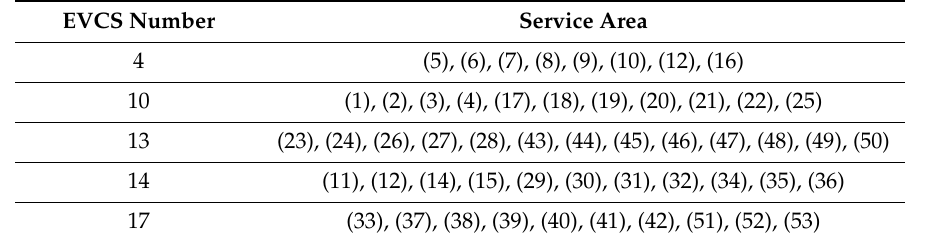
Table 4. The planning cost of the optimal solution. Table 5. The list of selected charging stations and corresponding service areas.